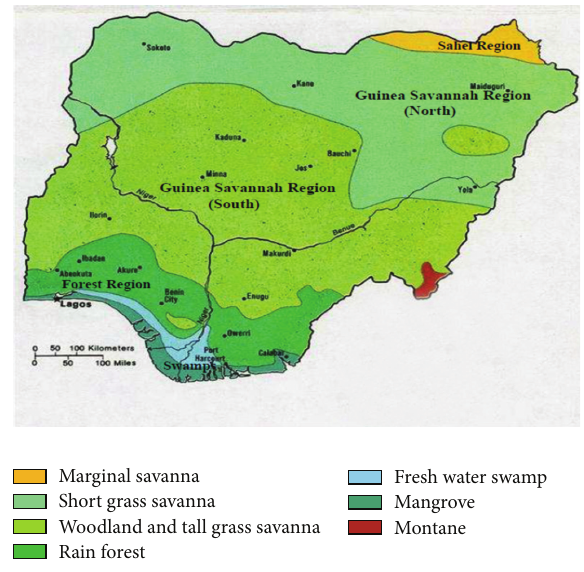
Figure 1: Sampling zoned according to the vegetation types in